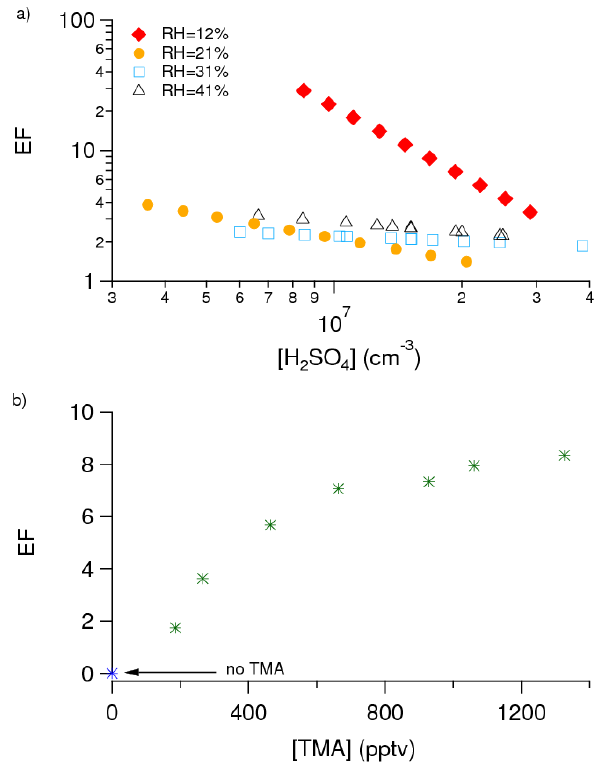
Fig. 3. (a) The measured EF as a function of [H 2 SO 4 ] (in the range of 5 × 10 6 − 6 × 10 7 cm − 3 ) at RH=12% (red diamonds), 21% (orange circles), 31% (light blue squares), and 41% (black triangles). (b) EF as a function of [TMA] (180–1350pptv) at [H 2 SO 4 ]=1 × 10 7 cm − 3 and RH =